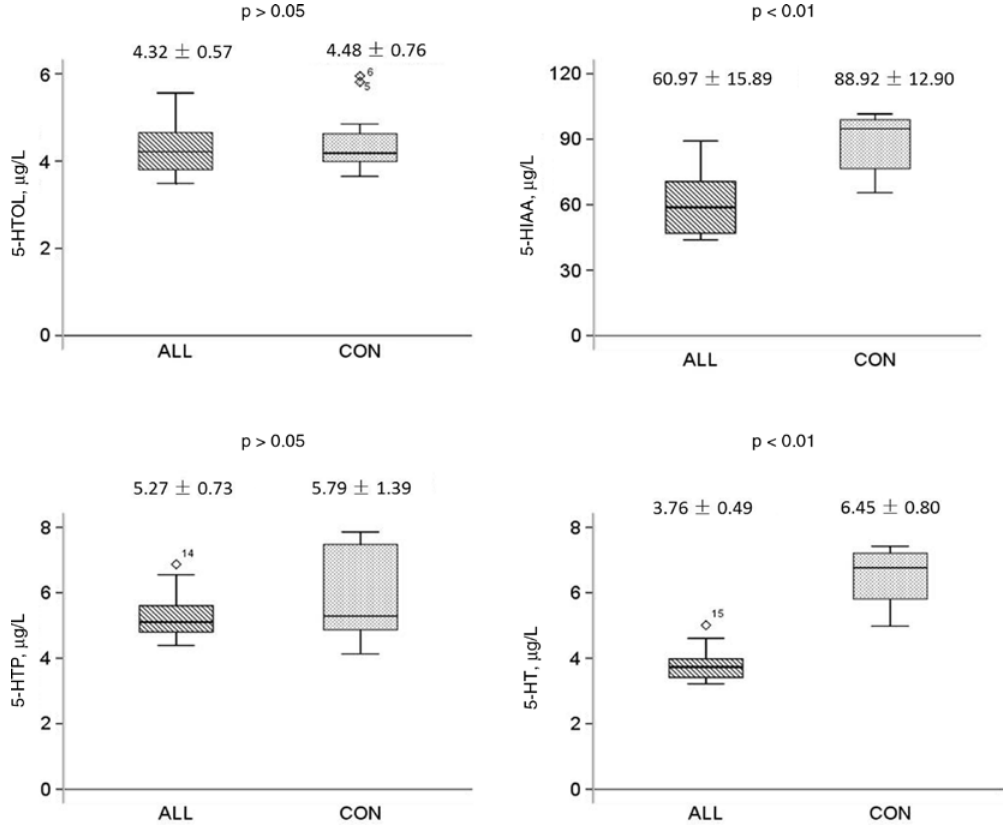
Figure 2: Difference in the excretion levels of 5-HTOL, 5-HIAA, 5-HTP and 5-HT in CSF from the ALL and CON